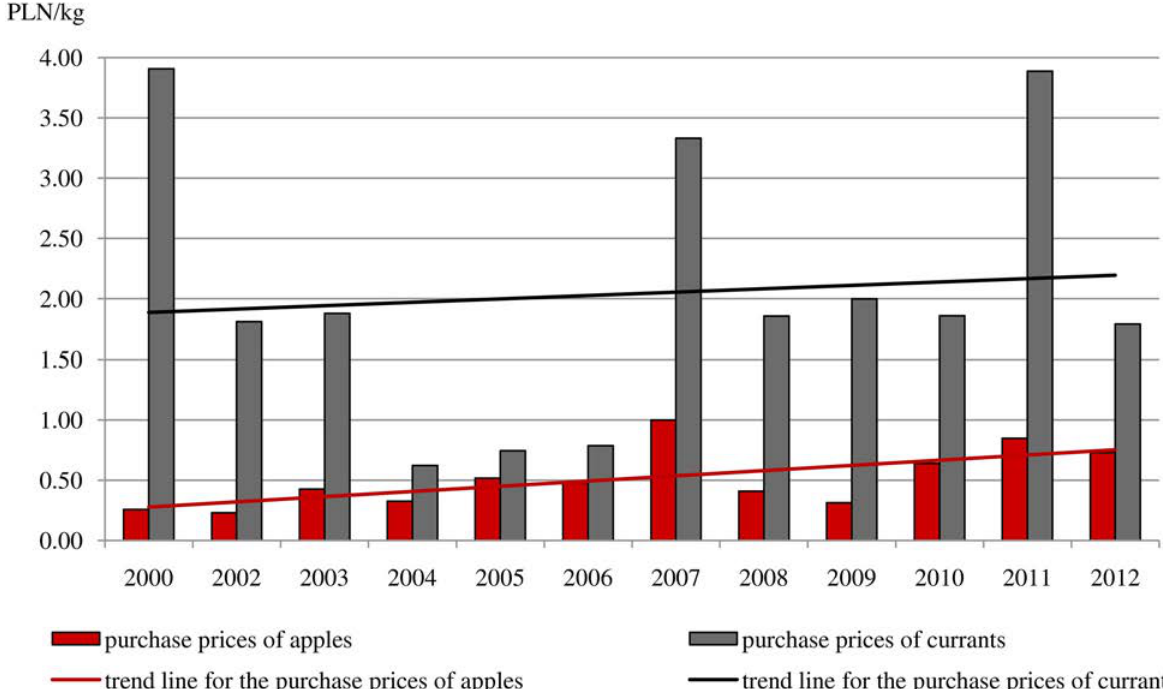
Fig. 2. Average purchase prices of apples and currants in the period 2000–2012. Source: own calculations based on the 2007, 2009, 2011 and 2013 Statistical yearbooks of